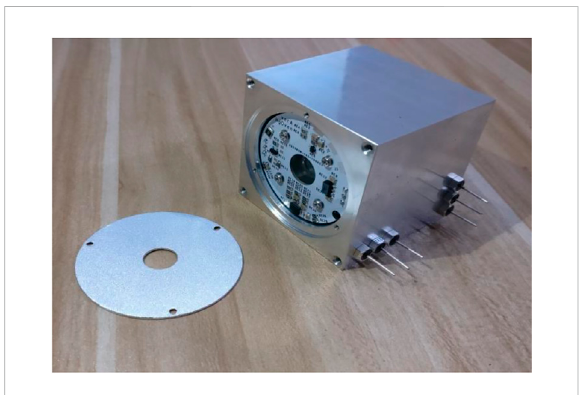
FIGURE 13 A photo of the mercury lamp. The lamp shell is a cube with a side length of 8 cm.